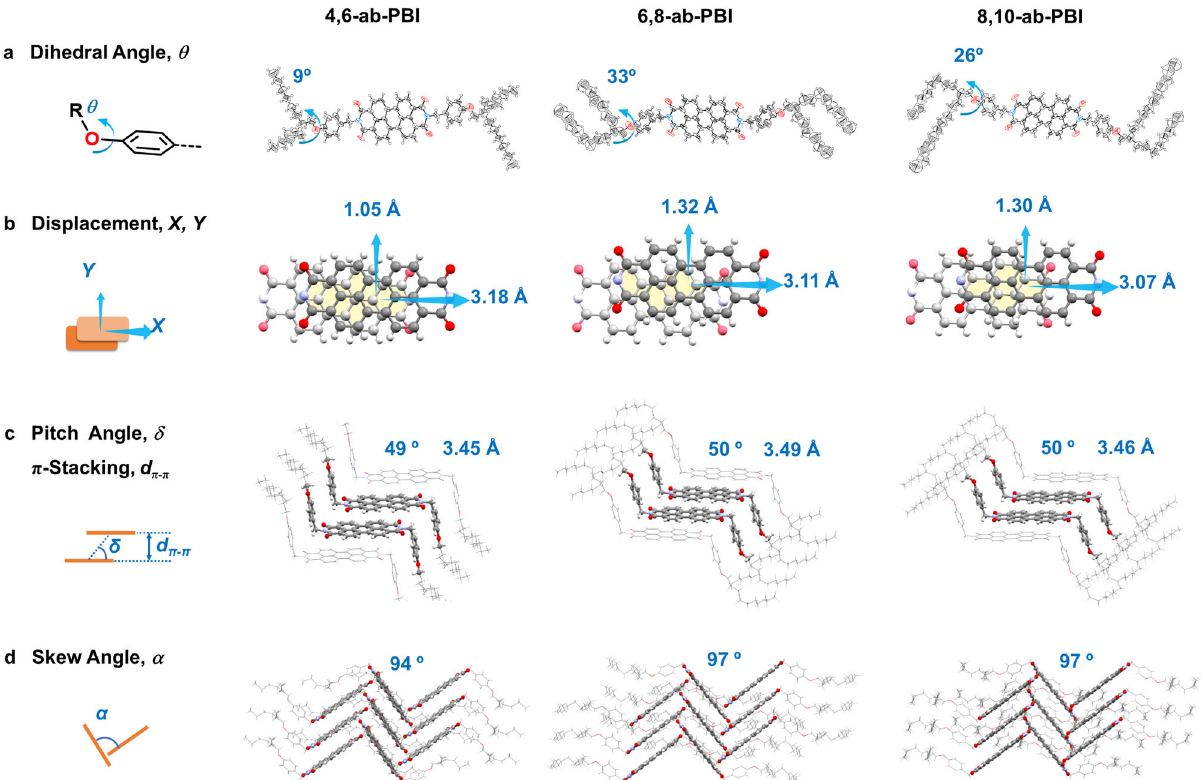
Fig. 2 | X-ray crystal structures of the compounds under study. a ORTEP drawings of the molecular structures (ellipsoid probability 50%), indicating the dihedralangle ( θ ) betweenthe benzyland alkoxy groups. b Perspectiveviewalong the π - π stackingdirection,indicatinglongitudinal( X )andtransversedisplacements